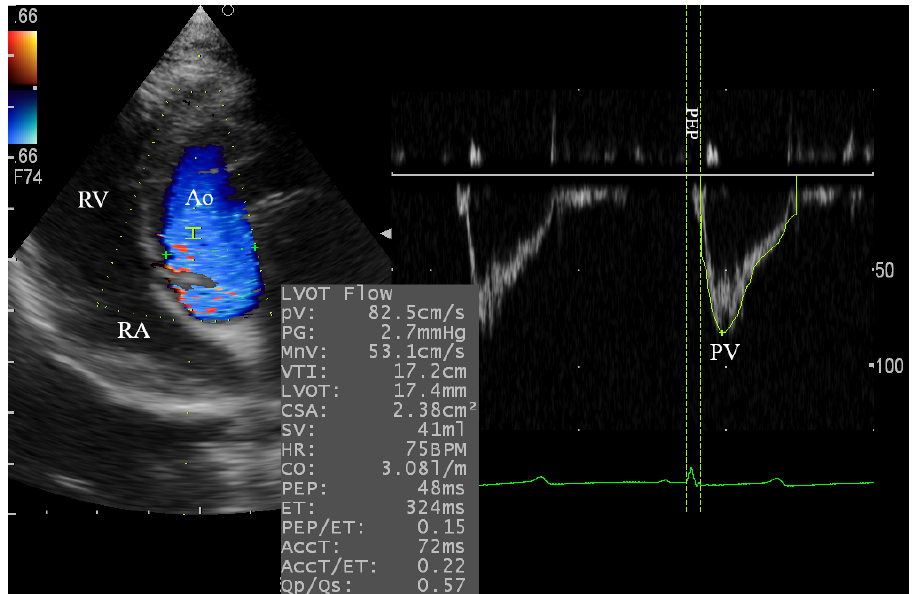
Figure 3. Pulsed wave Doppler echocardiography for evaluation of the aortic blood flow in goats through the left apical 5-chamber view. The sample volume was adjusted at 2.0 mm. Ao, aorta; RA, right atrium; RV, right ventricle; PV, peak velocity; PEP, pre-ejection time.